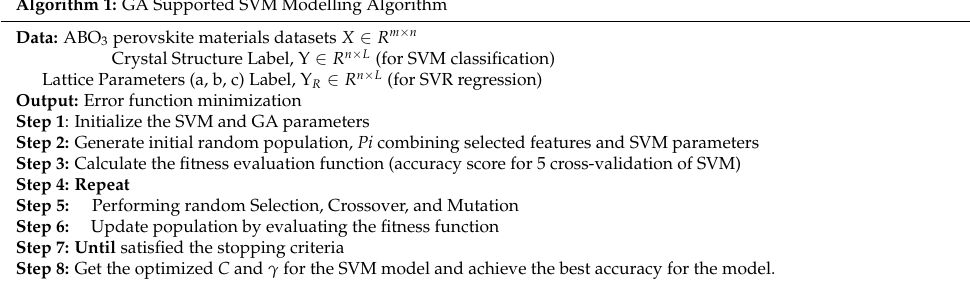
Algorithm 1: GA Supported SVM Modelling Algorithm